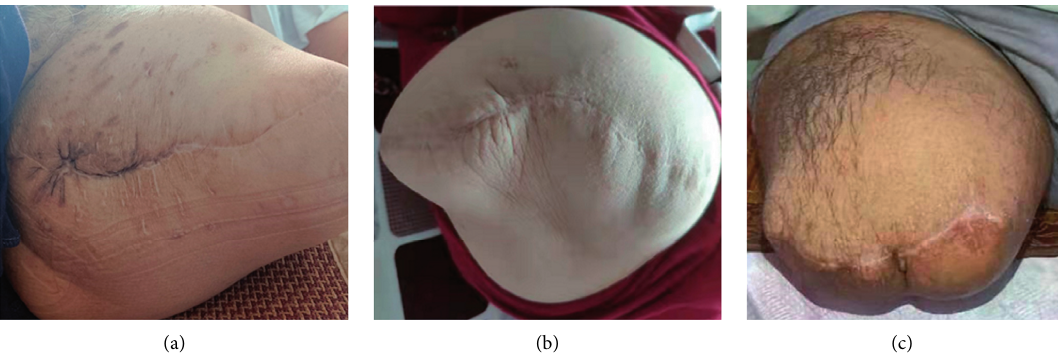
Figure 5: The healing situation of patients in the latest follow-up. (a) Patient 1 in 3 years after amputation. (b) Patient 2 in 3 years after amputation. (c) Patient 3 in 1 year after